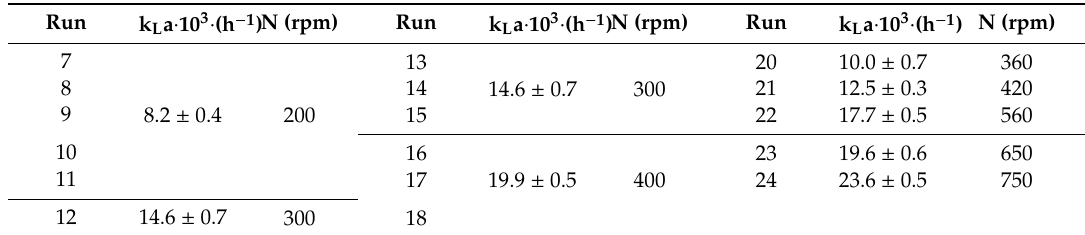
Table 4. Mass transfer coe ffi cient values calculated for runs 7 to 18 (shake flasks) and runs 20 to 24 (STBR); all runs conducted at low